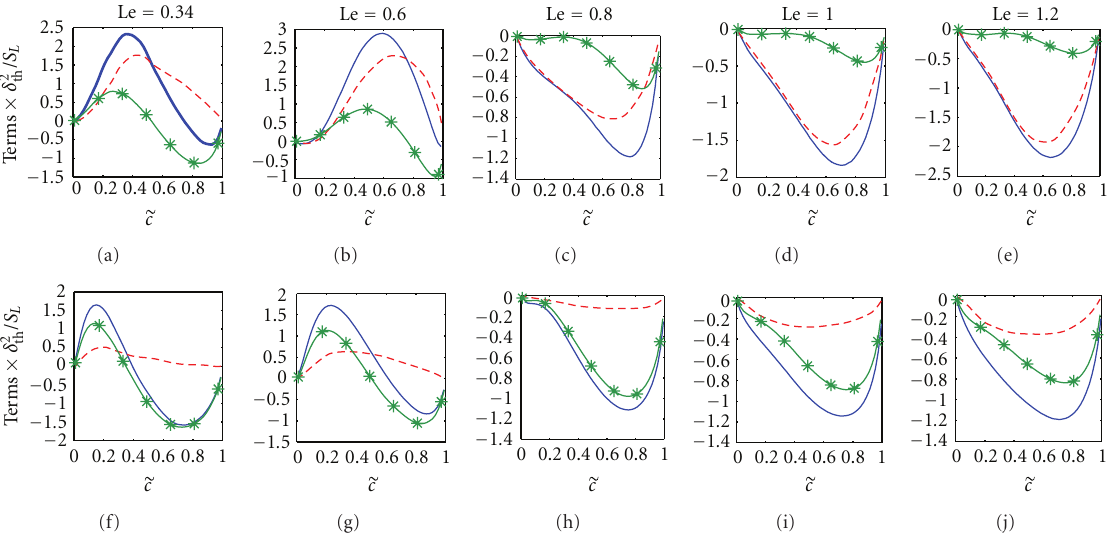
(cid:2) N /∂x Σ C Figure 2: Variation of ( S d ∇ · ) s Σ gen (solid line), C mean = ( S d ) s ∂ ( N i ) i gen (dashed line) and sg (asterisk line) conditionally averaged s in bins of (cid:2) c across the flame brush for filter sizes Δ = 8 Δ m ≈ 0 . 8 δ th (top row): (a) Le = 0 . 34 (1st column); (b) Le = 0 . 6 (2nd column); (c) Le = 0 . 8 (3rd column); (d) Le = 1 . 0 (4th column); (e) Le = 1 . 2 (5th column) and for filter size Δ = 24 Δ m ≈ 2 . 4 δ th (bottom row): (f) Le = 0 . 34 (1st column); (g) Le = 0 . 6 (2nd column); (h) Le = 0 . 8 (3rd column); (i) Le = 1 . 0 (4th column); (j) Le = 1 . 2 (5th column). All terms are ensemble averaged on (cid:2) c isosurfaces in Figure 2 and subsequent cases. All the curvature terms in this and subsequent figures are . normalised by S L /δ 2 th As the range of κ m values obtained on a flame surface increases with increasing flame wrinkling, the magnitude of − 4( Dκ 2 m ) s increases with decreasing Le, which in turn leads to increasing magnitude of − 4( Dκ 2 m ) s Σ gen and C sg2 (see Figure 3). The positive contribution of C sg1 overcomes the negative contribution of C sg2 towards the unburned gas side of the flame brush for the Le = 0 . 34 and 0.6 flames (i.e., cases (a) and (b)) and yields a net positive contribution of C sg towards the reactant side of the flame brush (see Figure 2). (cid:2) N The statistical behaviours of (( S r + S n ) ∇ · ) s Σ gen and (cid:2) N/ κ C 2 m = ∇ · sg1 depend on the nature of the curvature dependences of ( S r + S n ) and |∇ c | , and the variation of ( κ m ) s across the flame brush. The correlation coe ffi cients for ( S r + S n ) − κ m and |∇ c | − κ m for five di ff erent c isosurfaces across the flame brush for all the cases are shown in Figures 4(a) and 4(b), respectively. For all cases, S t = − 2 Dκ m remains negatively correlated with κ m with a correlation coe ffi cient close to ( − 1.0). However, Figures 4(a) and 4(b) demonstrate that Le significantly a ff ects the curvature κ m dependences of ( S r + S n ) and |∇ c | . It can be seen from Figures 4(a) and 4(b) that ( S r + S n ) and |∇ c | remain positively (negatively) correlated with κ m for the Le < 1 . 0 (Le > 1 . 0) flames, whereas both ( S r + S n ) and |∇ c | show weak curvature dependences in the unity Lewis number flame. The positive correlations between ( S r + S n ) and κ m , and between |∇ c | and < 1 flames. The κ m strengthen with decreasing Le for the Le physical explanations for the observed influences of Lewis number on the curvature dependence of ( S r + S n ) and |∇ c | have been discussed elsewhere [25–27] and thus will not be discussed in this